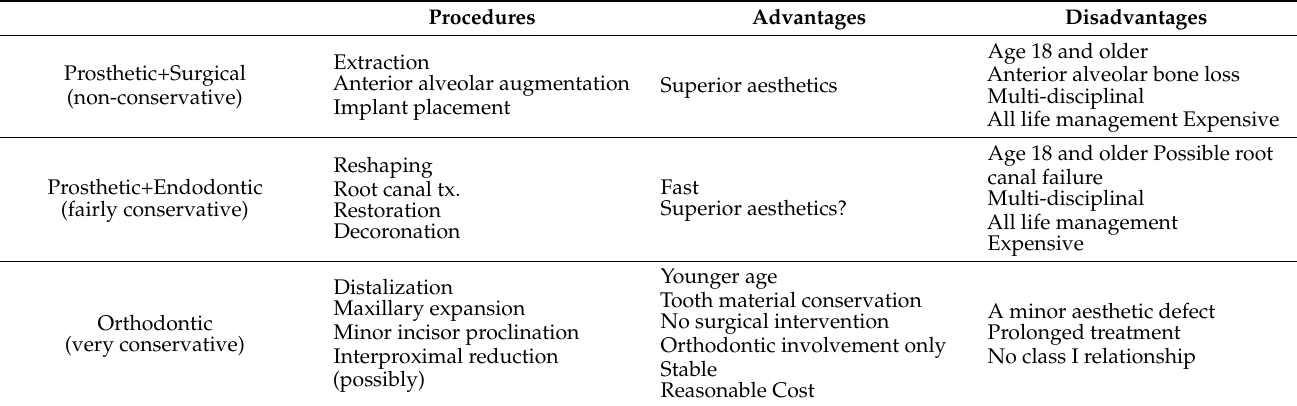
Table 1. The three treatment alternatives for gemination.